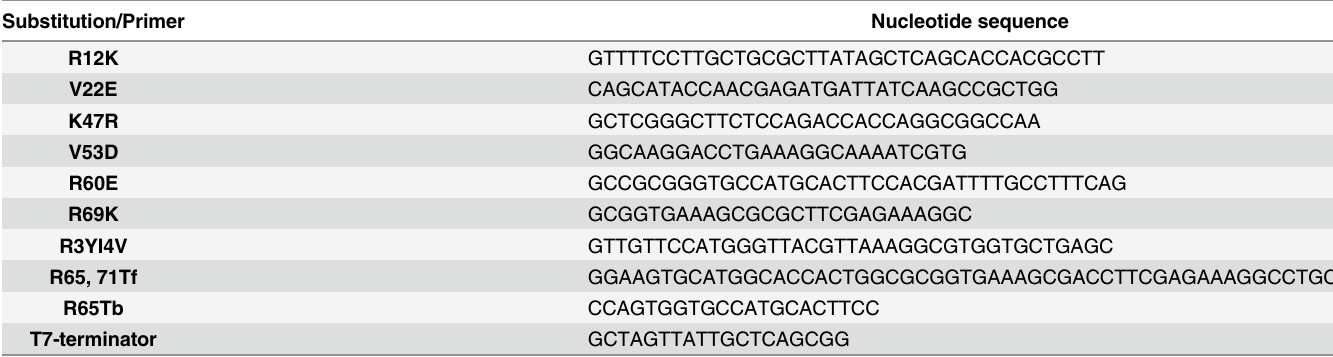
Table 1. List of the primers used for mutagenesis of rWT